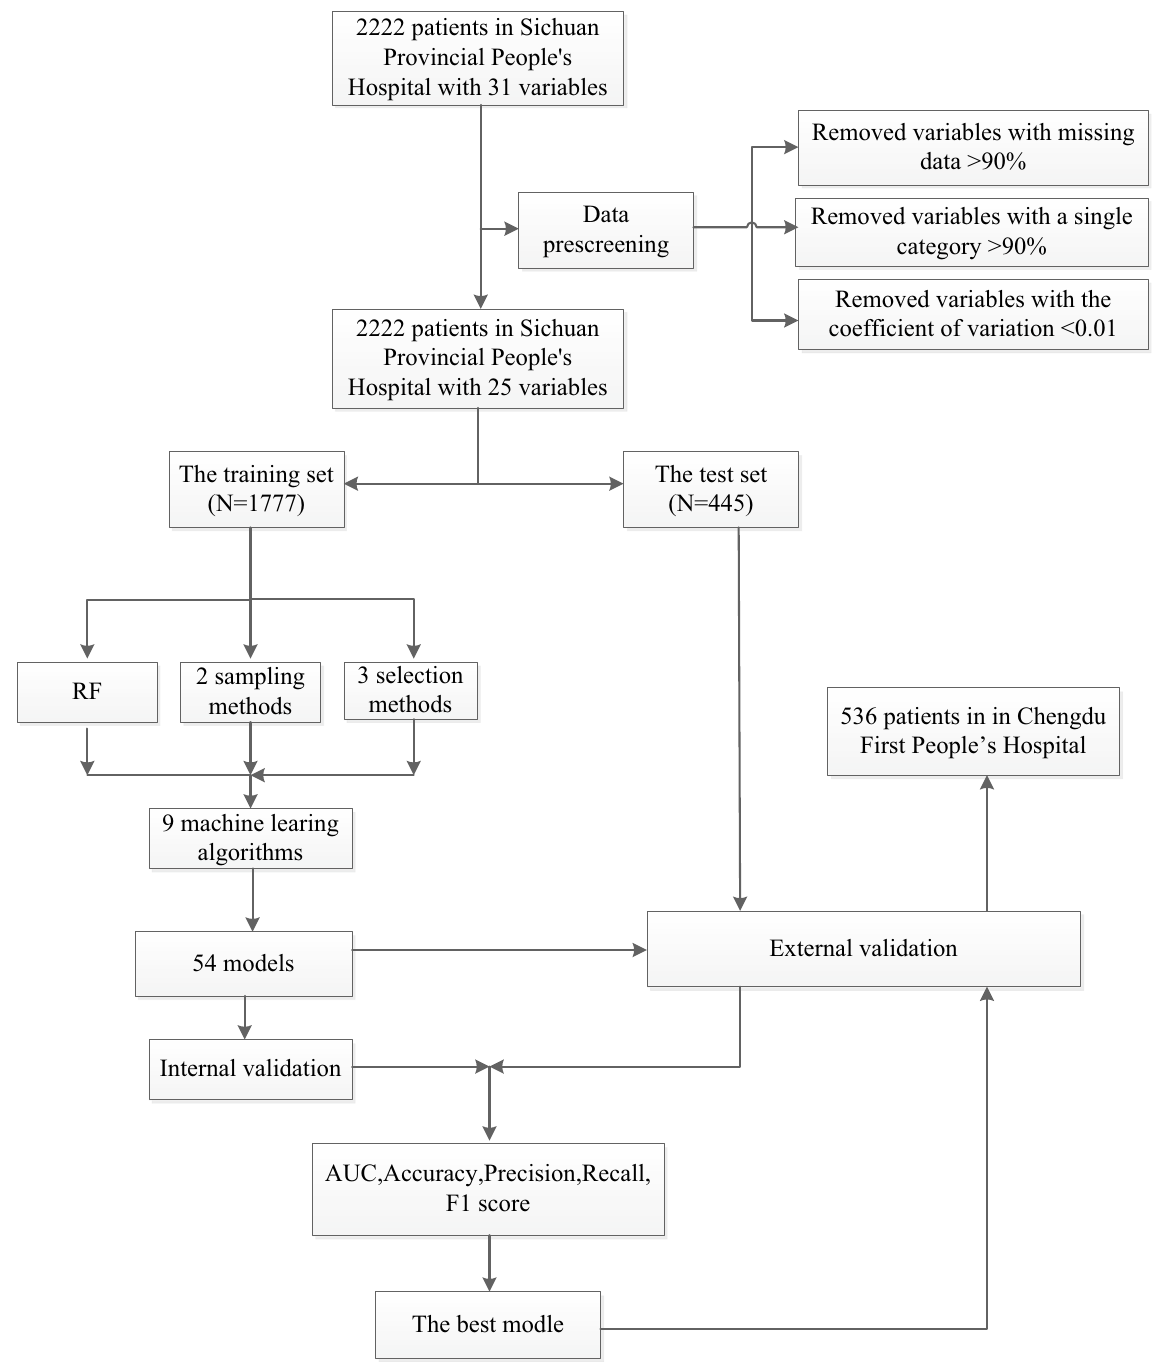
Figure 4. Flowchart. RF random forest, AUC area under the